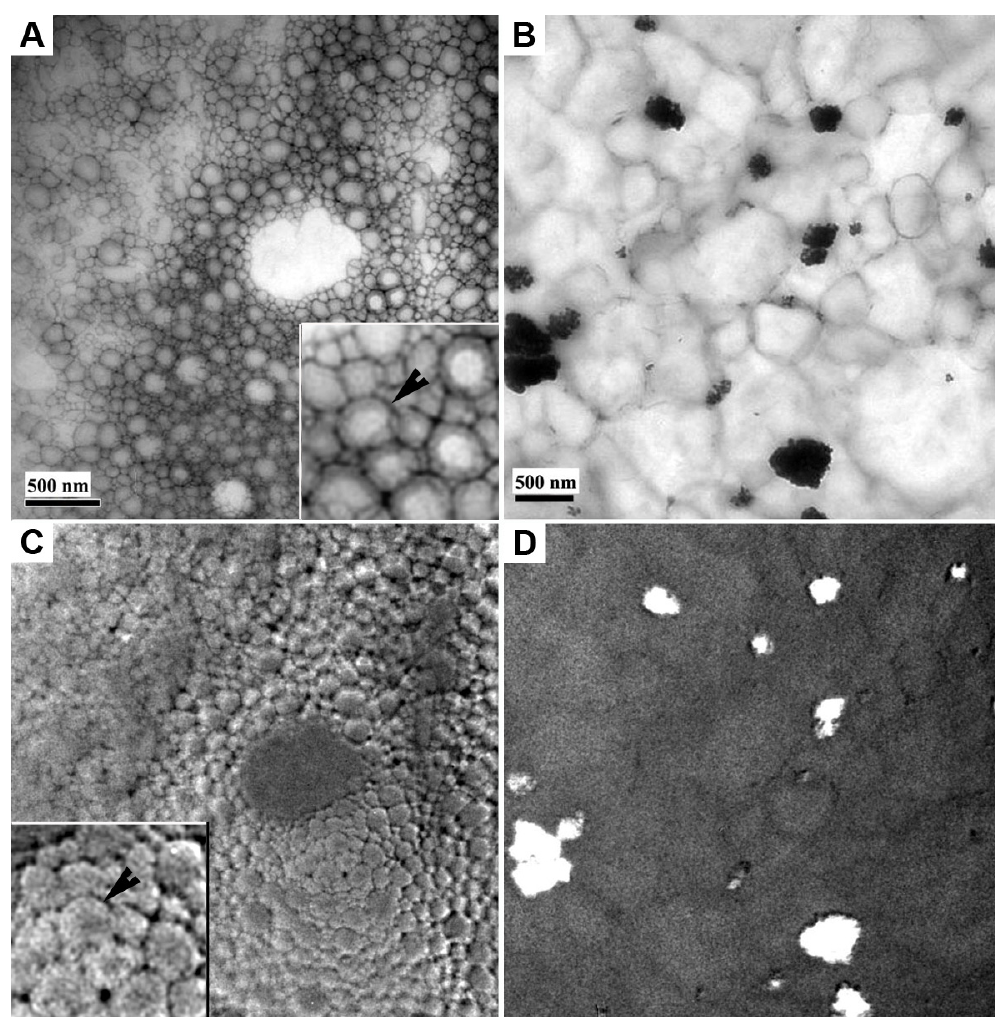
Figure 4. Conventional two-dimensional TEM projection images of the model nanoemulsion and macroemulsion with incorporated titanium dioxide particles and corresponding surface profiles as mathematically extracted from the EFTEM data. Both samples were negatively stained with a 2% aqueous uranyl acetate solution. Images ( A ) and ( B ) show zero-loss filtered bight field TEM images of the nanoemulsion ( A ) and the macroemulsion ( B ). The images below show the corresponding surface profile for the nanoemulsion ( C ) and for the macroemulsion ( D ) Black arrows indicate a hollow droplet shells composed of dried surfactant film. Scale bars represent 500